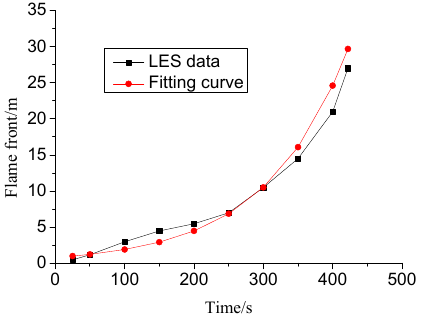
Figure 10. Surface temperatures of building’s exterior.